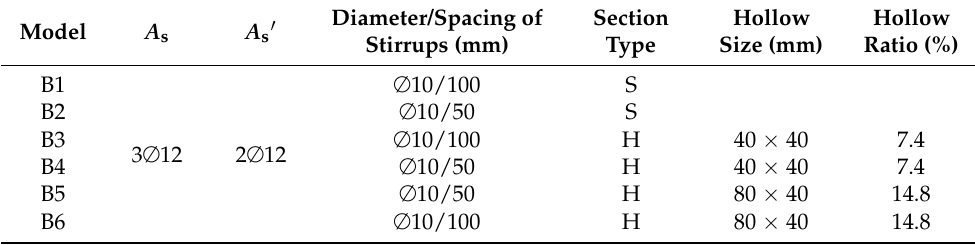
Table 1. Details of the numerical beam models.